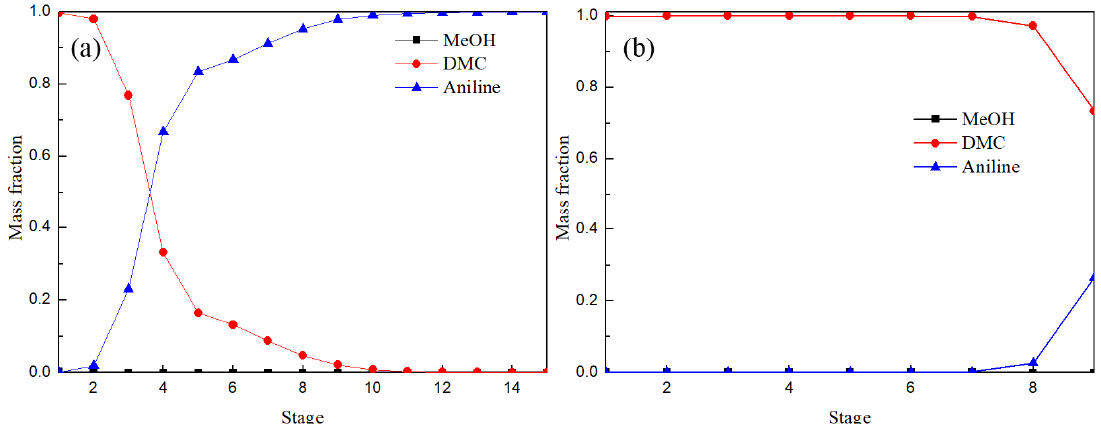
Figure 13. Liquid composition profiles of ERC ( a ) and attached column of EDWC ( b ).